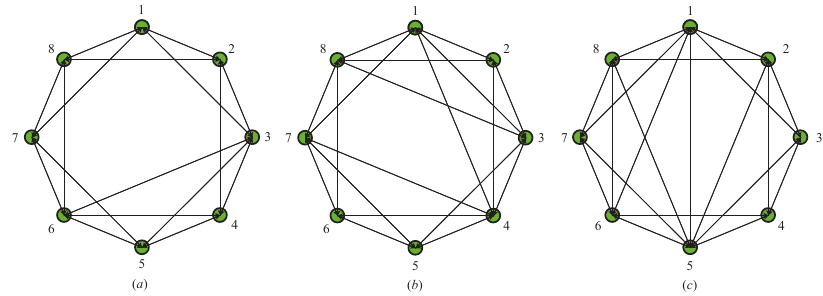
Figure 4. Topological structures of a small-world network with 8